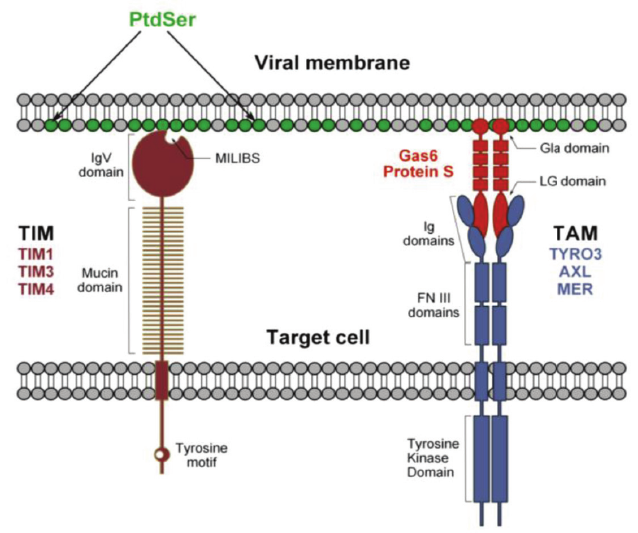
Figure 2. Hypothetical model for flavivirus recognition by TIM and TAM